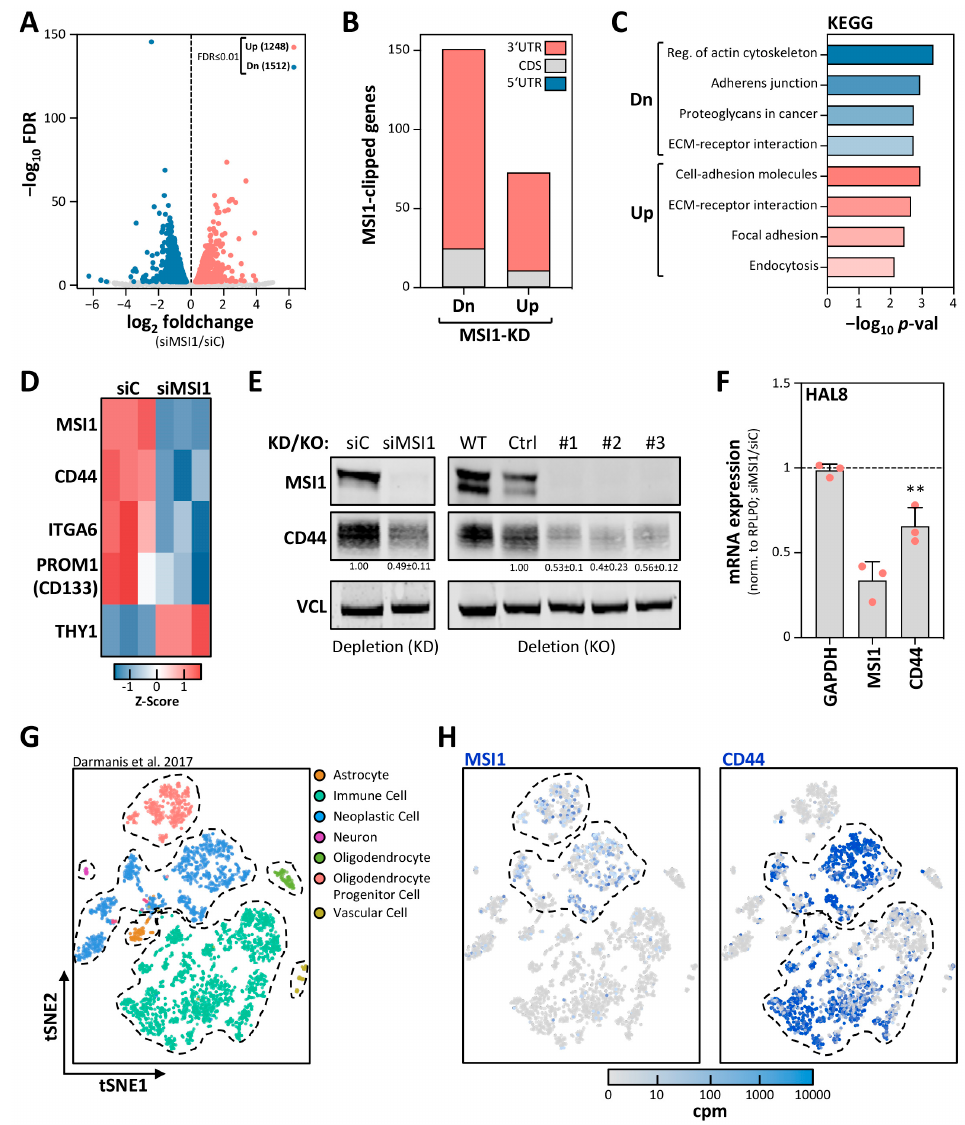
Figure 2. MSI1 promotes CD44 expression in GBM-derived cells. ( A ) Volcano plot of the mRNA fold changes plotted against the FDR for siMSI1 versus siC in KNS42 cells, determined by mRNA-seq. Significantly differentially expressed genes (FDR ≤ 0.01) are highlighted in blue (downregulated) and red (upregulated). Numbers of differentially expressed genes are indicated. ( B ) The association of MSI1 protein with mRNA cis-elements, determined by CLIP [12], of significantly down- or upregulated genes (FDR ≤ 0.01) upon MSI1 depletion as in ( A ) is depicted. ( C ) KEGG analyses performed on all genes identified to be clipped in ( B ), by using Enrichr [25]. ( D ) Heatmap presentation depicting the expression of significantly differentially expressed (FDR ≤ 0.01) CSC marker genes (as in Figure S1E) in KNS42 cells, generated with Heatmapper [29]. ( E ) Representative Western blot analysis of indicated proteins of siC- and siMSI1-transfected KNS42 cells. VCL served as the negative and loading control. ( F ) Relative mRNA expression determined by RT-qPCR for the indicated transcripts upon transient MSI1 depletion in the primary tumorspheres HAL8, 72 h post-transfection. ( G , H ) 2D-tSNE analysis presentation of all single cells included in the study ( n = 3589) by Darmanis et al. (2017) [3,28]. Distinct identified types of cell clusters are indicated ( G ). MSI1 and CD44 expression levels are indicated for each single cell in increasing shades of blue, as indicated by a color code ( H ). Error bars indicate the standard deviation from three independent experiments. Statistical significance was determined by Student’s t -test (**, p ≤